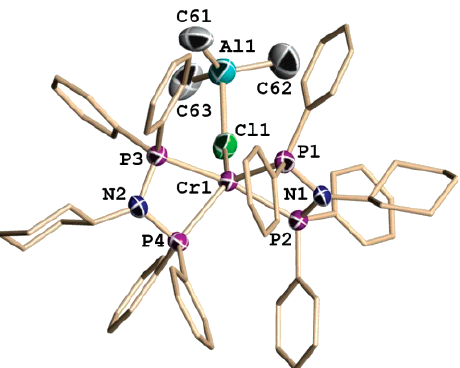
Figure 30. Plot of the Cr-containing cationic moiety of Cr08 with thermal ellipsoids of the non-carbon atoms drawn at the 30% probability level. Reprinted with permission from [242]. Copyright (2006) American Chemical Society.